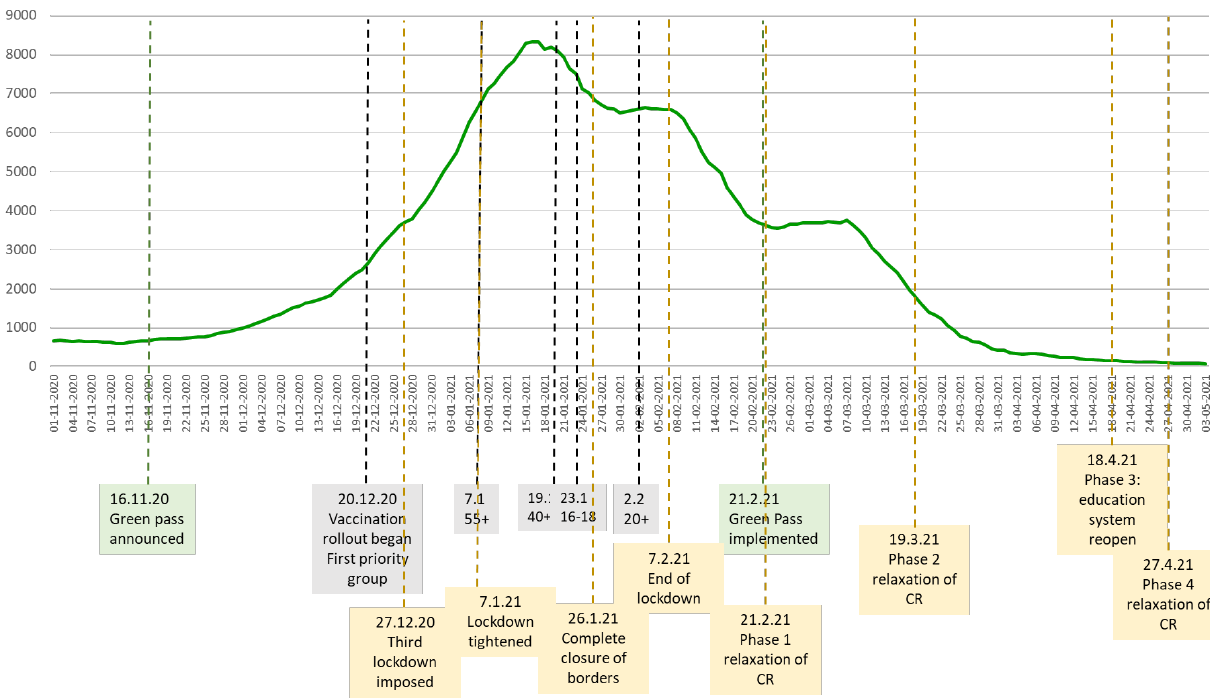
Figure 2. COVID-19 morbidity, vaccination rollout, public health responses, and the Green Pass. (Note: CR = COVID restrictions. Sources: Authors’ own compilation based on https://datadashboard.health.gov.il/COVID-19/general, accessed on 18 October 2021 and [12]).